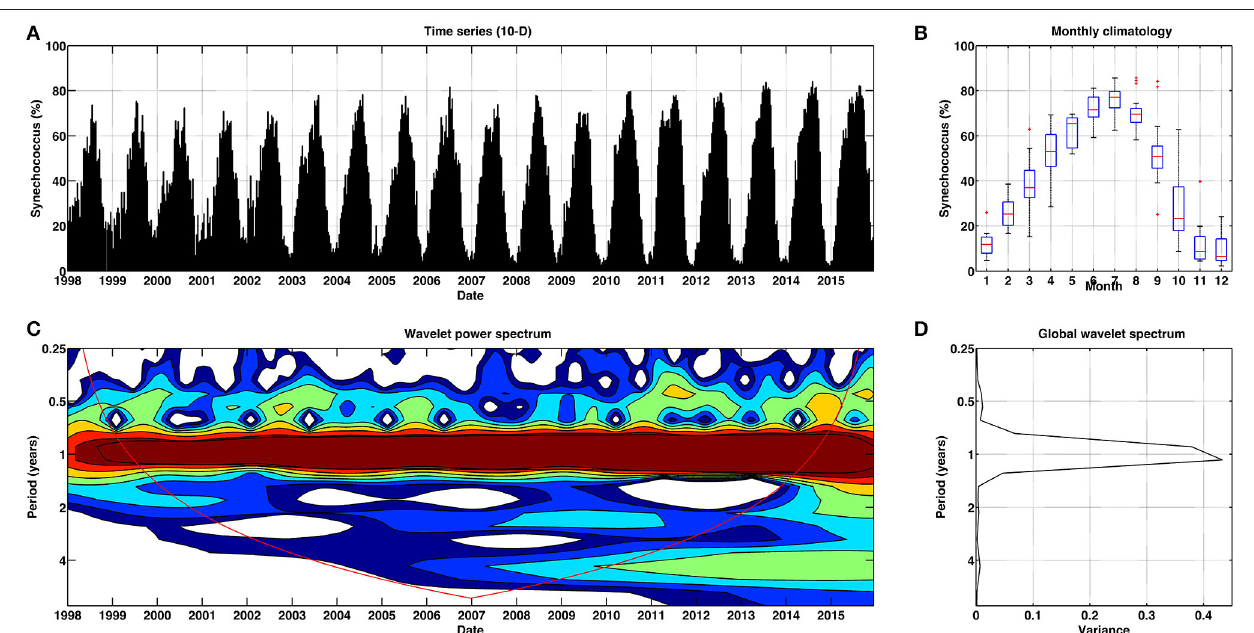
FIGURE 7 | Temporal patterns of variability for Synechococcus for Mediterranean Sea. (A) Temporal percentage (10-day) of Synechococcus . (B) Box plot (red lines stand for the median, blue box spans from the first to the second quartiles, and black lines represent 5th and 95th percentiles, respectively) of monthly climatology of Synechococcus . (C) Continuous wavelet power spectrum for the 10-day time series. Red line indicates the cone of influence, and is the region affected by the edges of the data and should not be considered. (D) Global wavelet spectrum for the 10-day time series.